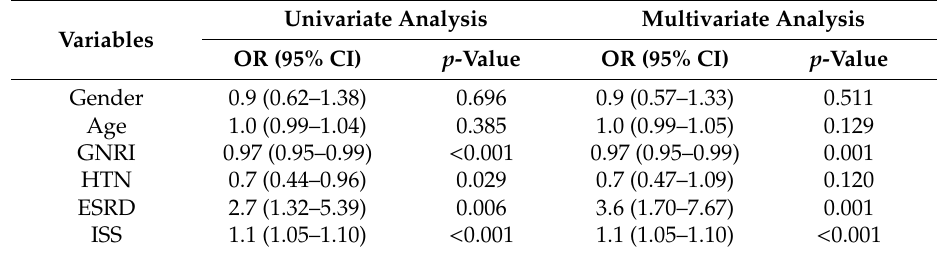
Table 2. Univariate and multivariate analysis to identify risk factors for mortality in older trauma patients in the intensive care unit.